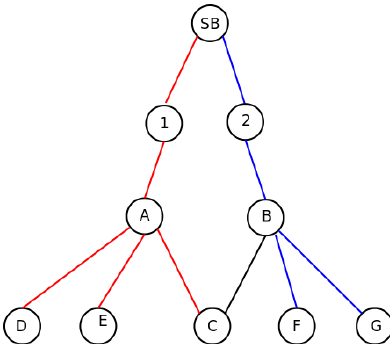
Figure 4. Slot allocation: Situation II. Figure 4. Slot Allocation - Situation II.